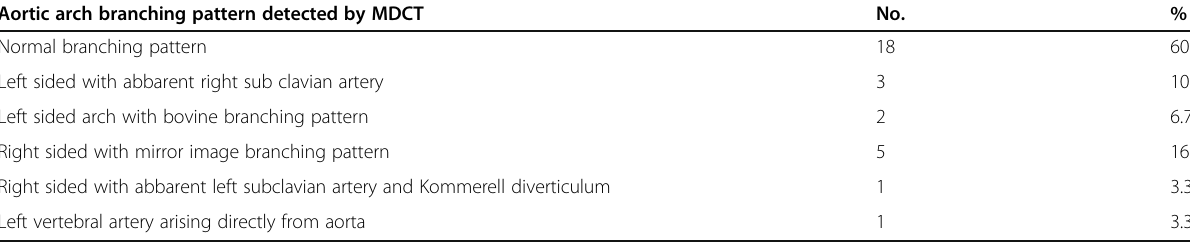
Table 4 Frequency of aortic arch branching pattern detected by MDCT ( n = 30) Aortic arch branching pattern detected by MDCT Normal branching pattern Left sided with abbarent right sub clavian artery Left sided arch with bovine branching pattern Right sided with mirror image branching pattern Right sided with abbarent left subclavian artery and Kommerell diverticulum Left vertebral artery arising directly from